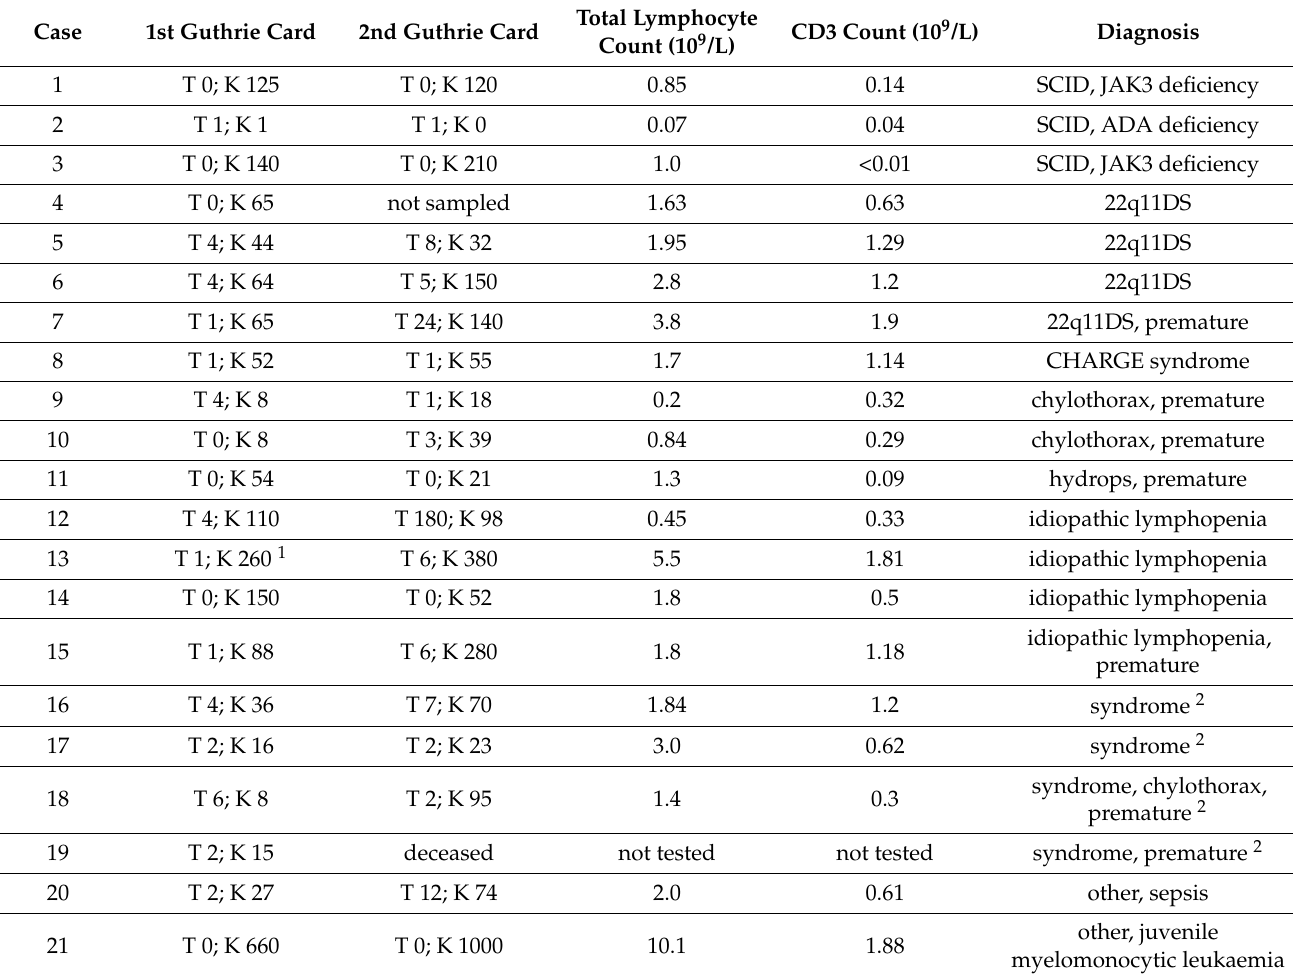
Table 3. Average TREC and KREC results of the first and second screening cards and the clinical diagnosis for true positive cases. TREC and KREC concentrations in